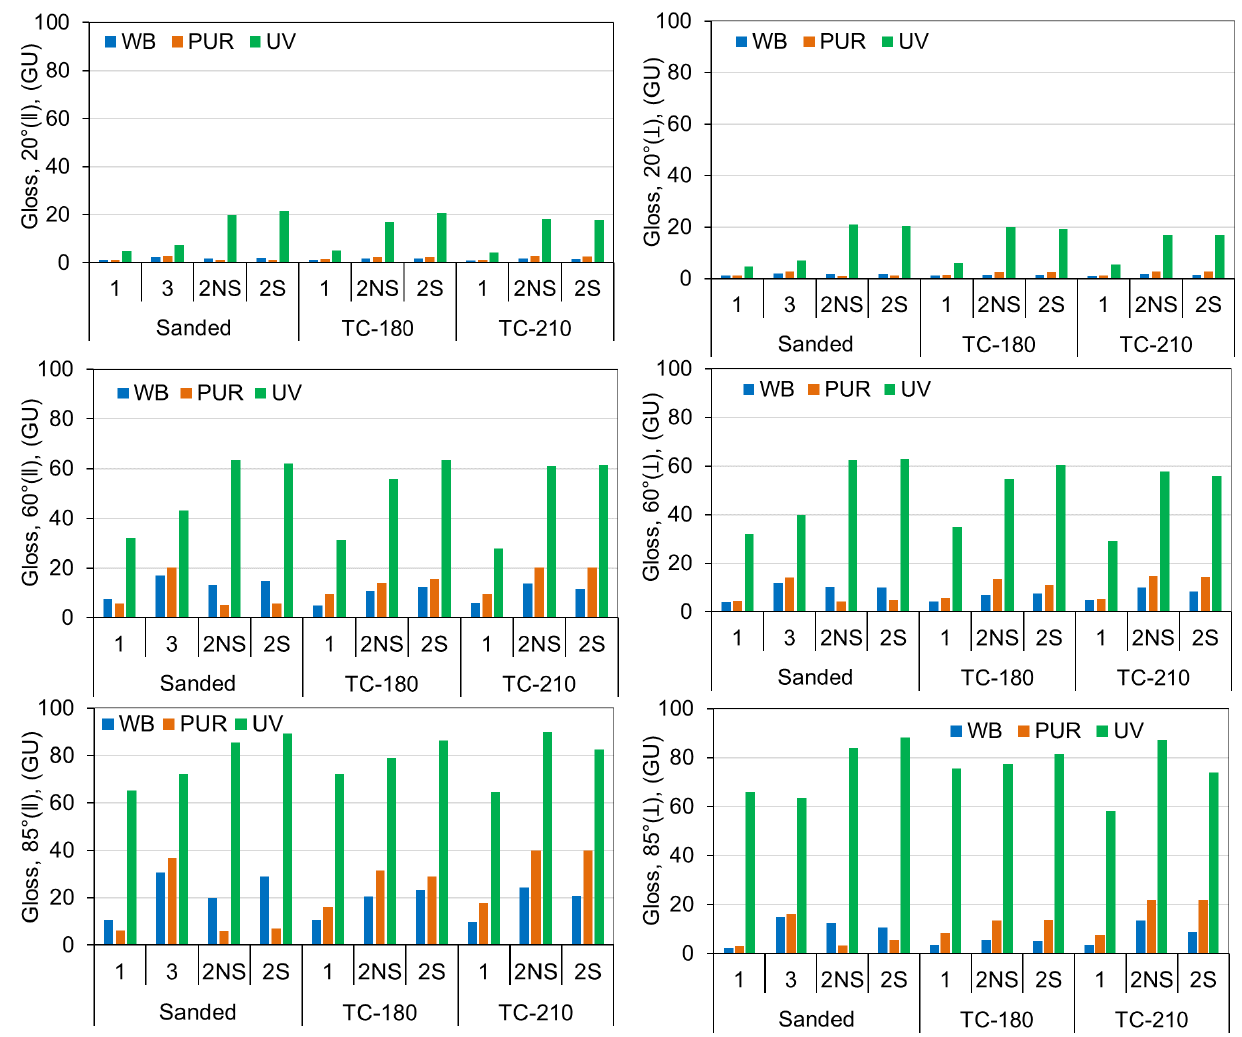
Figure 2. Impact of varnish type, number of varnish layers and method of pre-treatment on the gloss values of birch varnished surfaces along and across the fibers.